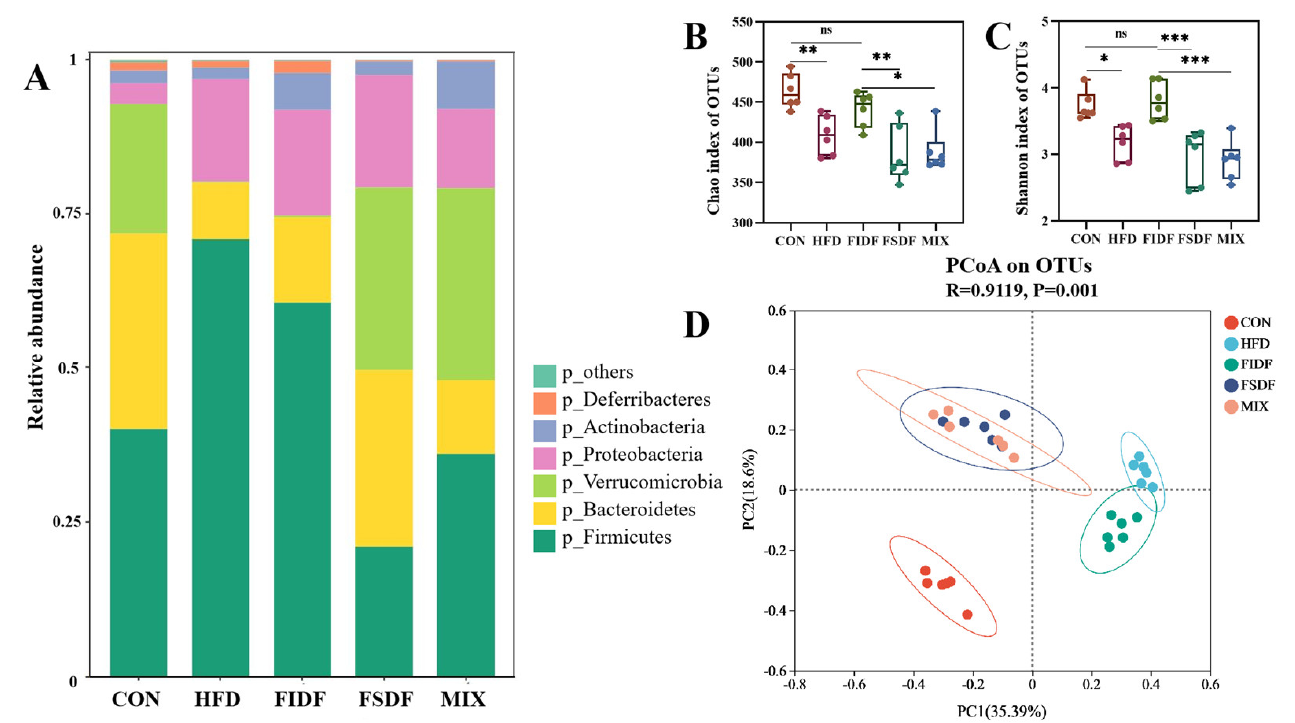
Figure 5. Effects of FIDF and FSDF on intestinal flora composition. ( A ) Microbial distribution at the phylum level. ( B ) Chao index at the OTU level. ( C ) Shannon index at the OTU level. ( D ) Principal coordinate analysis (PCoA) based on OTU levels. CON, control group; HFD, high-fat diet group; FIDF, group supplemented with FIDF alone; FSDF, group supplemented with FSDF alone; MIX, group supplemented with FIDF and FSDF together. Data are expressed as mean ± SEM ( n = 6). * p < 0.05; ** p < 0.01; *** p < 0.0001; ns, not significant.